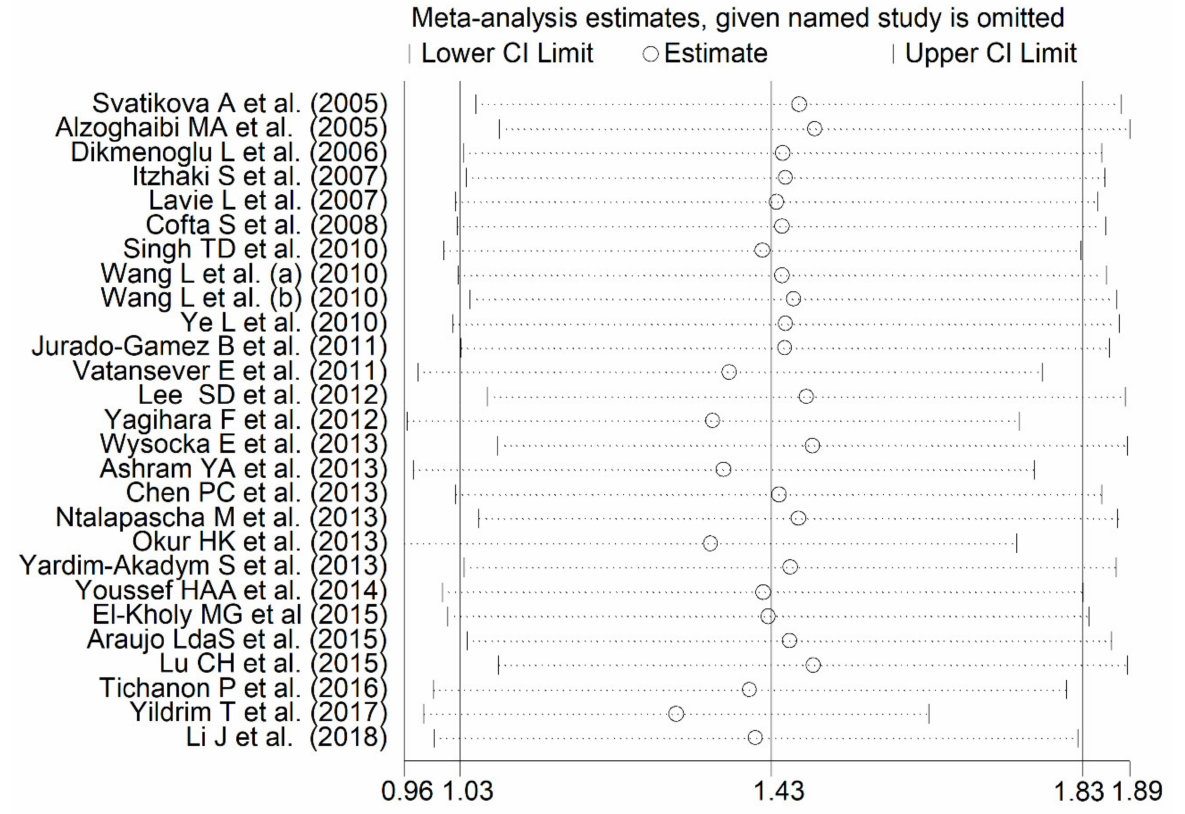
Figure 3. Sensitivity analysis of the association between MDA and OSA. The influence of individual studies on the overall standardized mean difference (SMD) is shown. The middle vertical axis indicates the overall SMD and the two vertical axes indicate the 95% confidence intervals (CIs). The hollow circles represent the pooled SMD when the remaining study is omitted from the meta-analysis. The two ends of each broken line represent the 95%